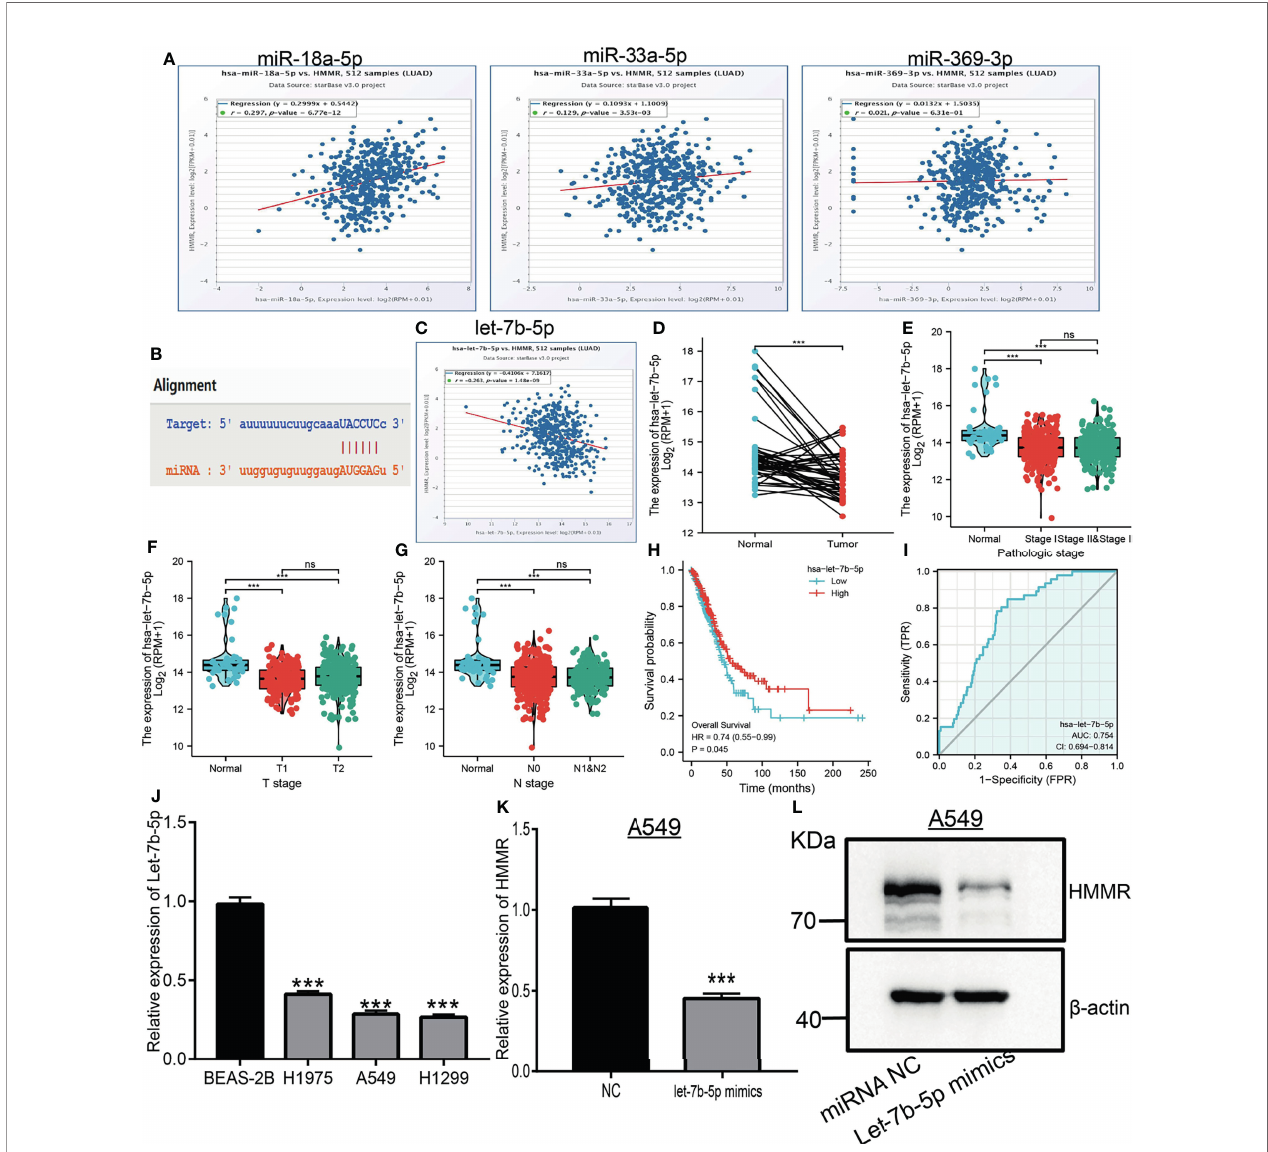
FIGURE 8 | Predicted and analysis the upstream miRNAs of HMMR in LUAD. (A) The correlation between the HMMR expression and miRNA-18a-5p, miR-33a-5p and miR-369-3p analysis by starBase. (B) The target sites between HMMR and hsa-let-7b-5p were predicted by starBase. (C) The correlation between the HMMR expression and hsa-let-7b-5p analysis by starbase. (D) The expression of hsa-let-7b-5p in LUAD analysis by TCGA. (E – G) The correlation between hsa-let-7b-5p expression and clinical features in LUAD. (H) The prognosis of hsa-let-7b-5p in LUAD analysis by kmplot. (I) The ROC curve of hsa-let-7b-5p in LUAD. (J) The expression of hsa-let-7b-5p in LUAD cells analysis by employed qRT-PCR assay. (K) The expression of HMMR after overexpression of hsa-let-7b-5p in LUAD cells analysis by qRT-PCR assay. (L) The expression of HMMR after overexpression of hsa-let-7b-5p in LUAD Cells analysis by western blot assay. NC, Negative control. P > 0.05 (ns), ***P < 0.001, was considered signi fi